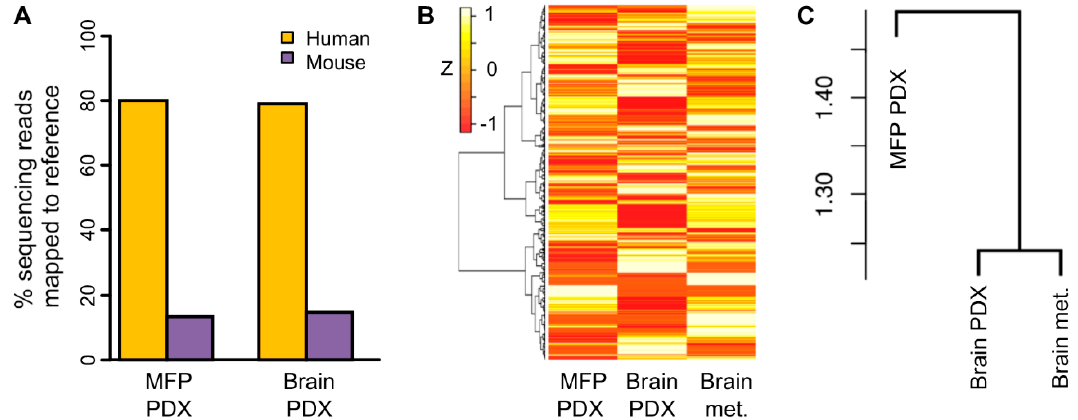
Figure 5. Comparison of gene expression of brain metastasis of breast cancer patient with its implant in mouse brain or mammary fat pad. Brain metastasis of one triple negative breast cancer patient was used for this experiment. Tumor was prepared with the mincing method for implantation (1 µL tumor + 2 µL phosphate-buffered saline) in mouse brain (Brain PDX) or mammary fat pad (MFP PDX) with the Pipette or Forceps method, respectively. Implanted tumors were then passaged three times at the same implantation site before they were harvested for RNA sequencing. ( A ) Mapping of RNA sequencing reads of PDX samples to reference human and mouse transcriptomes. Gene expression of the brain metastasis and implanted tumors was examined by RNA sequencing. ( B ) Heatmap of gene expression is shown for the 25,012 genes identified as expressed among the human and PDX tumors. Gene expression values are Z scaled, and gene clustering is unsupervised. ( C ) Unsupervised hierarchical clustering of gene set variation analysis scores of the three samples for the mSigDb Reactome gene set collection. Dendrogram heights are indicated. For clusterings, cosine distance metric and Ward agglomeration method were used. Sequencing reads that originated from mouse cells in PDX tumor stroma were excluded from the gene expression data to generate the plots in panels B and C.